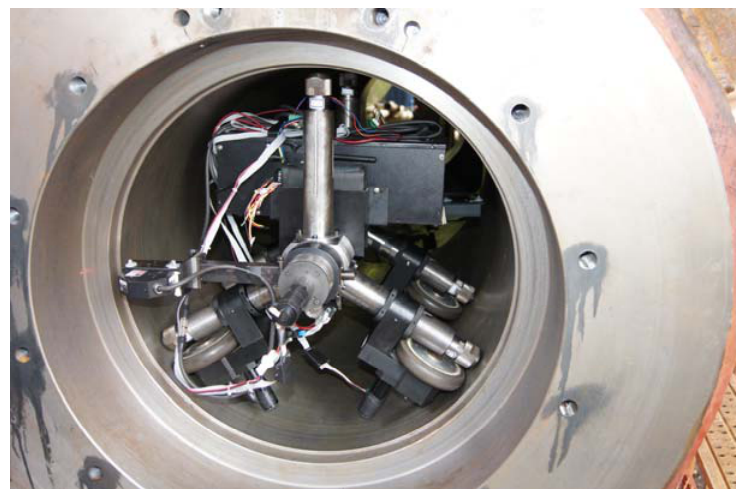
Figure 7. Field experiment on the measurement